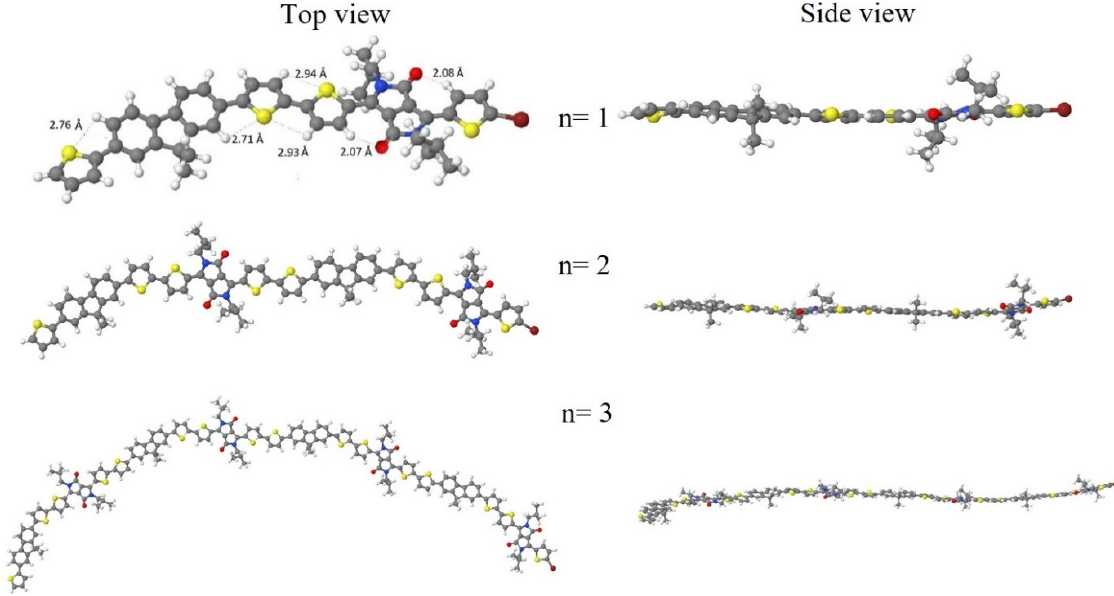
Figure 13. Calculated geometries of the ( PFDPP ) n polymers with n = 1, 2, and 4 units.